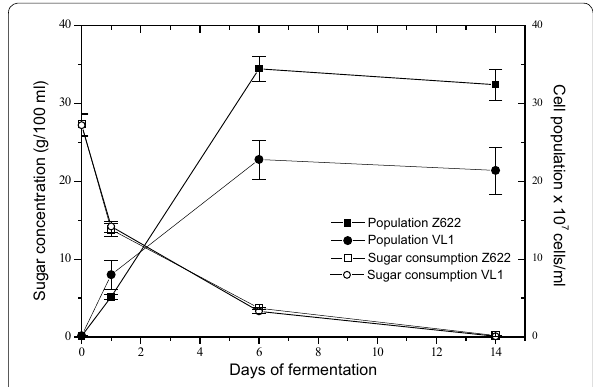
Fig. 1 Fermentation profiles of S. cerevisiae strains Z622 and VL1. Statistical evaluation was performed using the program Microcal Origin 5.0 (Microcal Software,